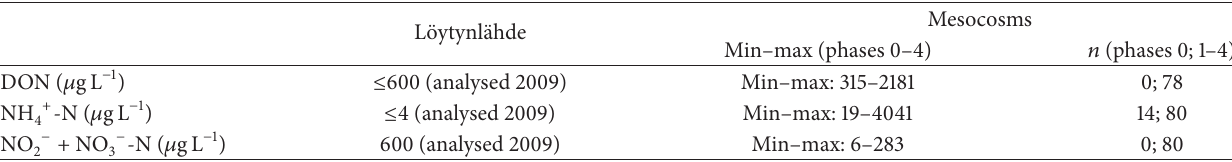
Table 4: Concentrations of nitrogen fractions in L¨oytynl¨ahde spring water and the range (min–max) in the water samples from the meso- cosms at phases